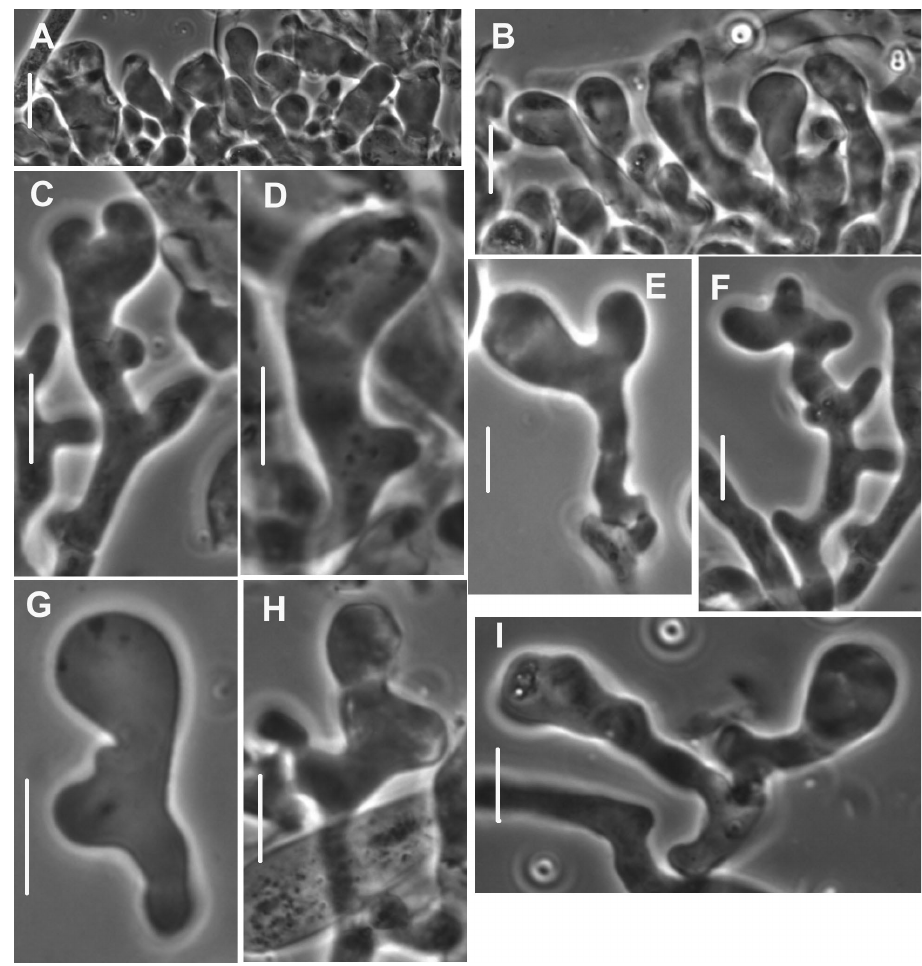
Figure 35. Mycetinis kallioneus . Pileipellis structures. A, B Overview of irregular hymeniform layer C–I Individual pileipellis elements. Standard bars = 10 µm. TB 85-209 (TUR).